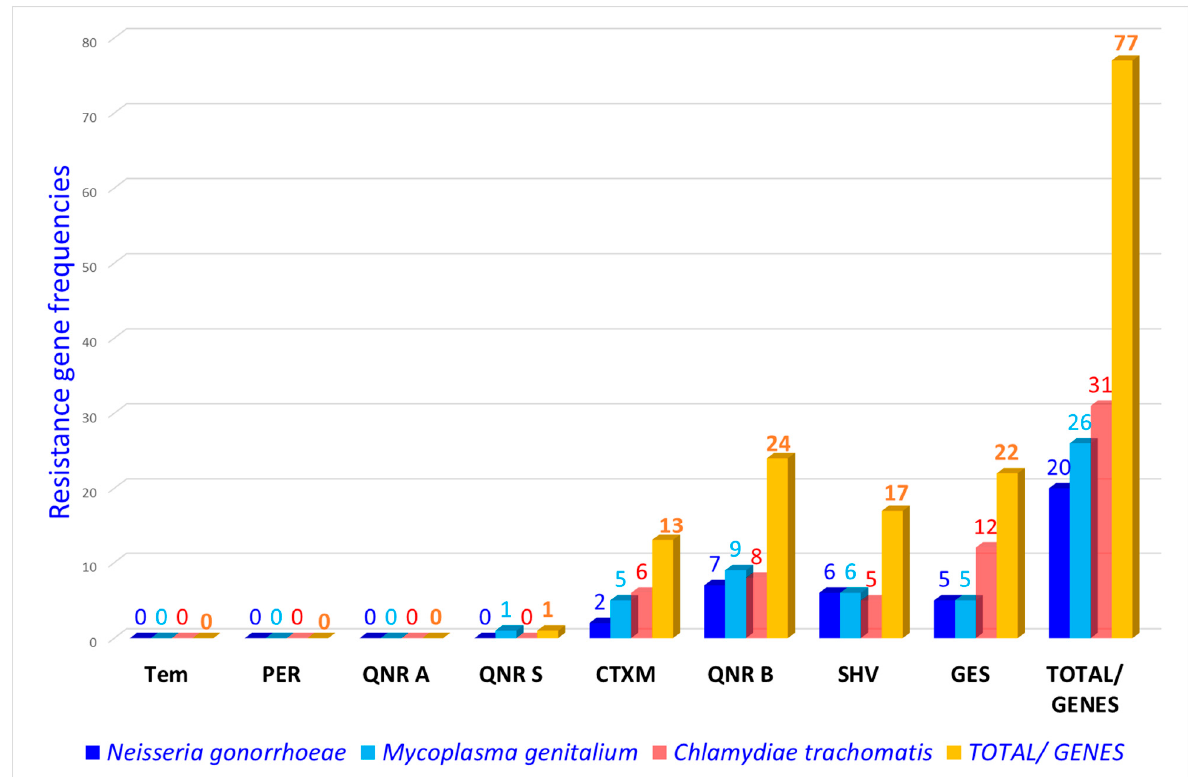
Figure 3. Antibiotics resistance genes as a function of bacteria.